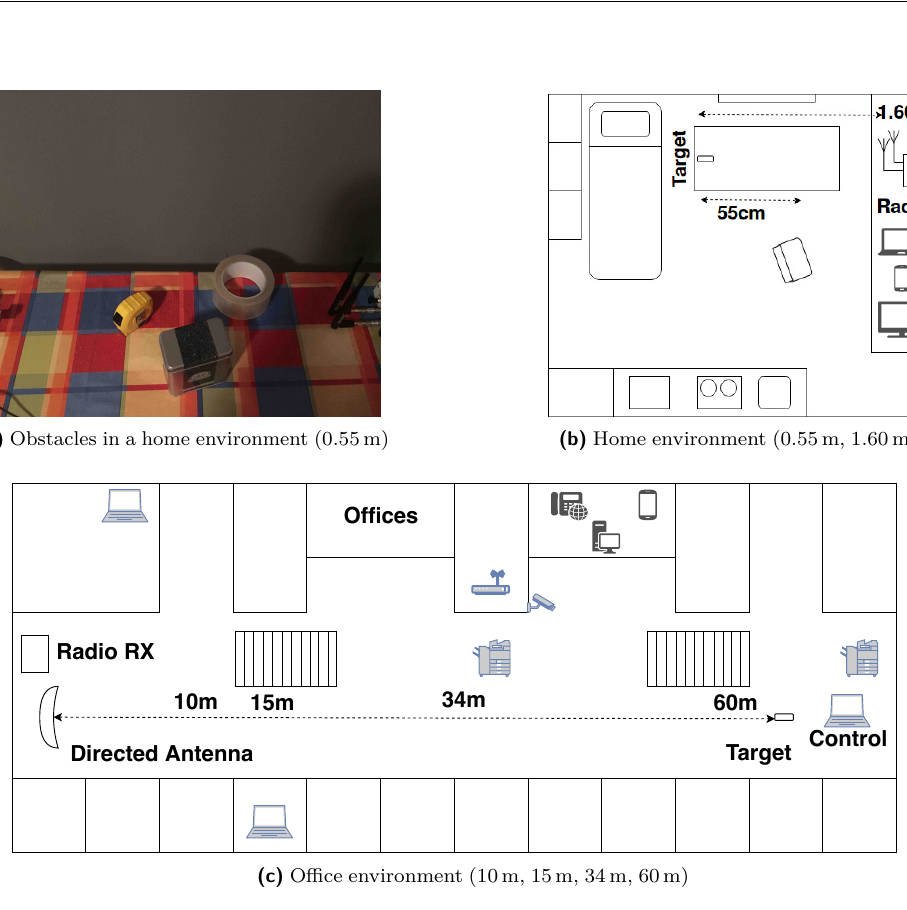
Figure 20: Some more challenging attack